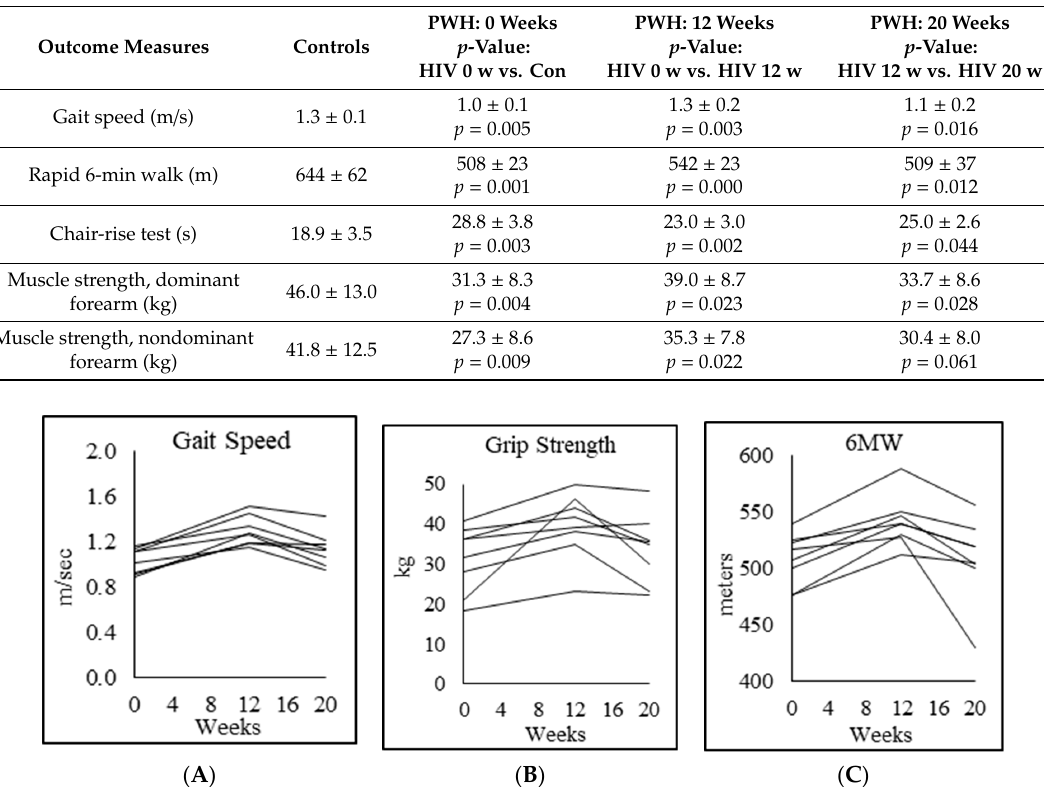
Table 6. Physical function.